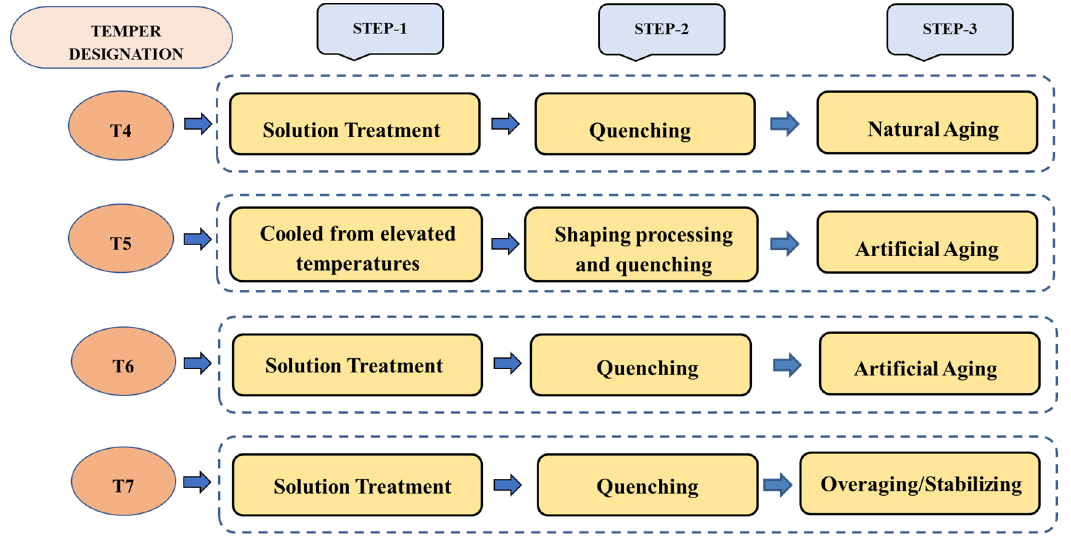
Figure 4. Schematic representation of commonly used temper designations in heat treatment.